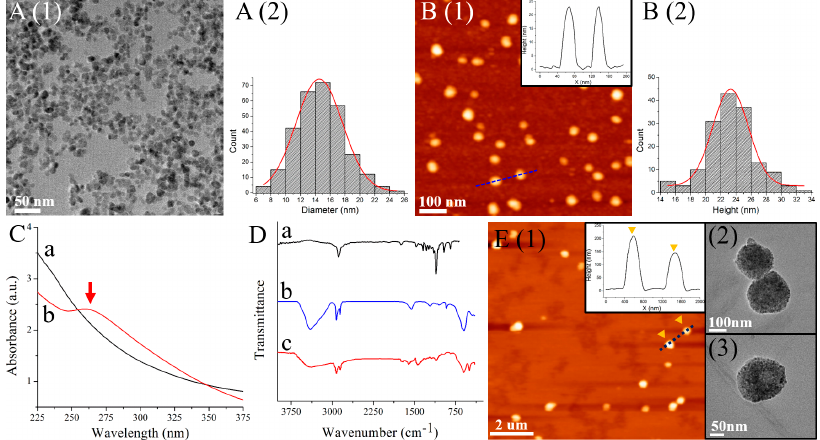
Figure 2. ( A ) TEM results of AMNPs and corresponding size distribution; ( B ) AFM results of AMNPs and corresponding size distribution; ( C ) UV-Vis spectra of APTES-Fe 3 O 4 (black) and AMNPs (red); ( D ) FT-IR results of copolymer (black), AMNPs (blue) and MMs (red); ( E ) AFM results of MMs and the cross-section profile of the dashed blue line, and two zoom-in TEM images of MMs.